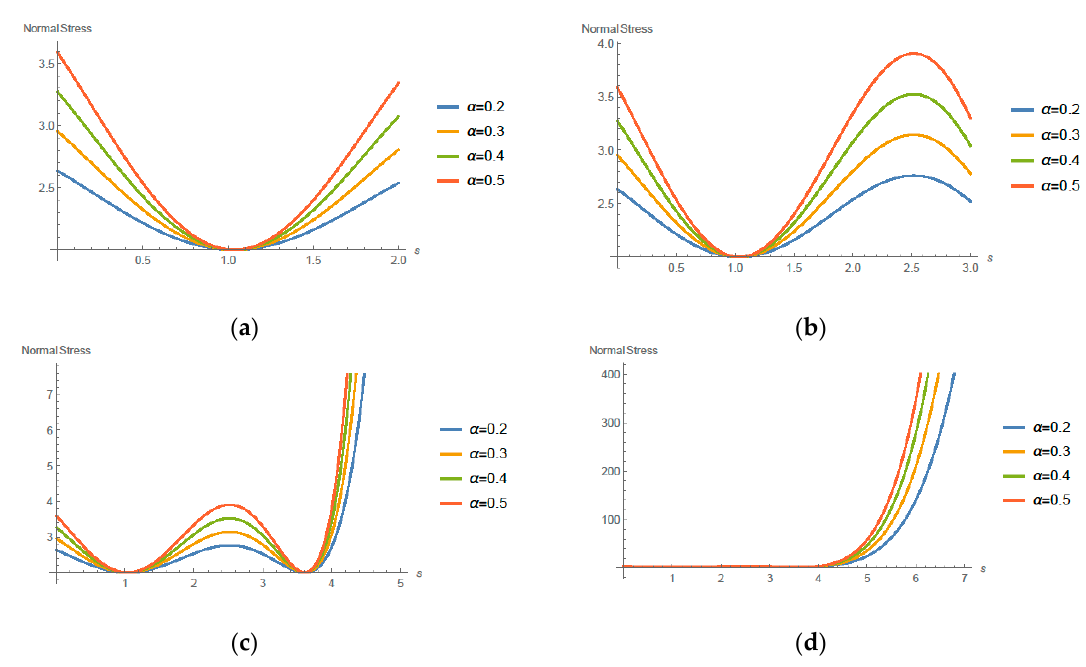
Figure 9. Normal stress at different values of α and 𝑠 . ( a ) with the s range of [0–2]; ( b ) with the s range of [0–3]; ( c ) with the s range of [0–5]; ( d ) with the s range of [0–7].